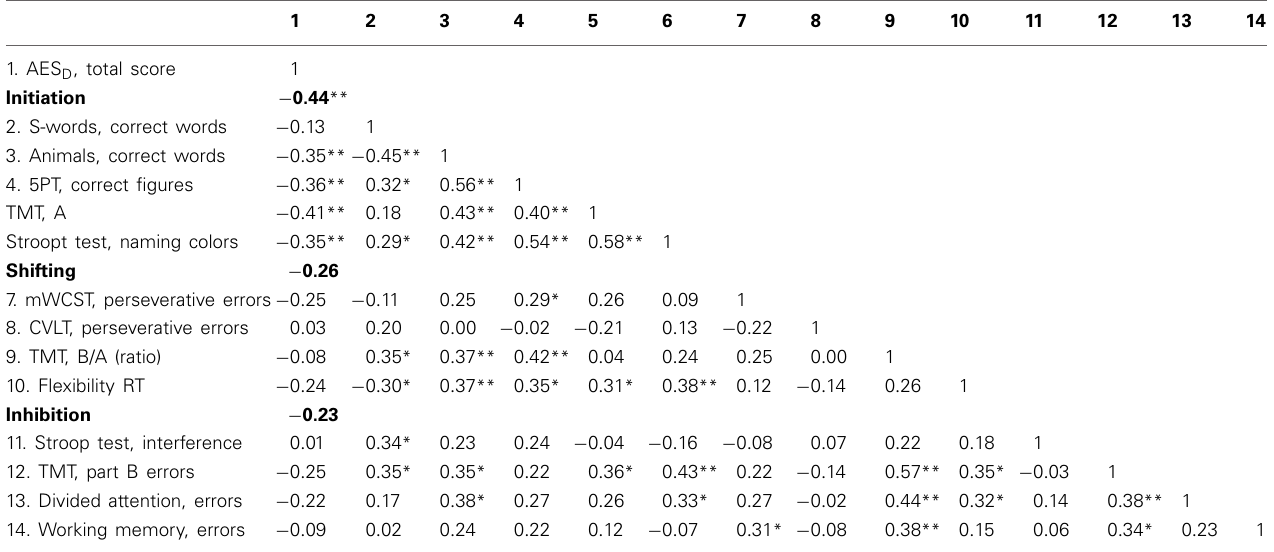
Table 3 | AES D , Apathy Evaluation Scale; 5PT, Five Point Test; TMT, Trail Making Test; mWCST, modified Wisconsin Card Sorting Test; CVLT, California Verbal Learning Test; RT, reaction time.